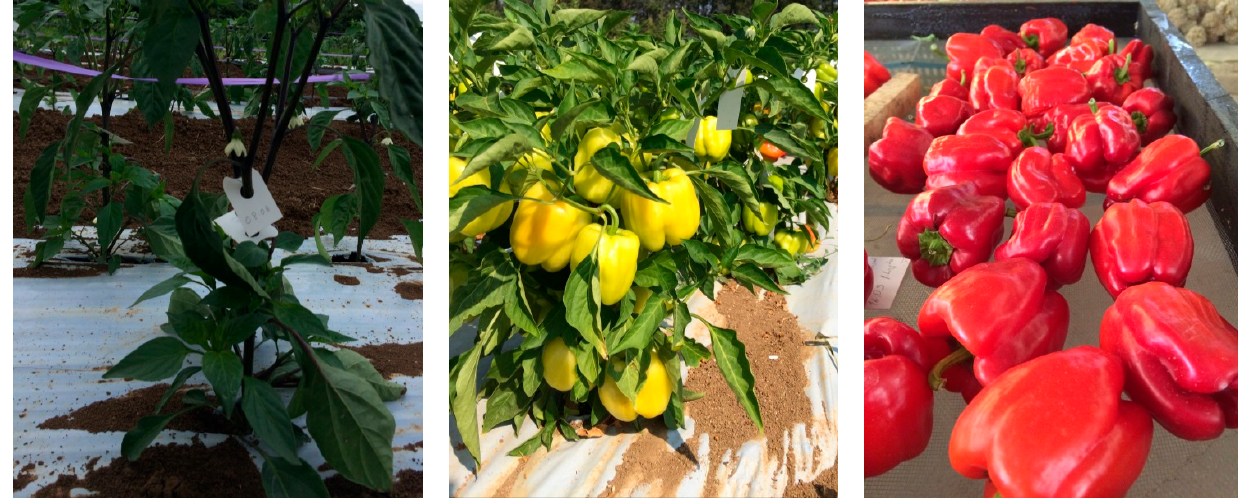
Figure 1. Labeled flowers and fruits of cv. “Kandil Dolma” pepper.